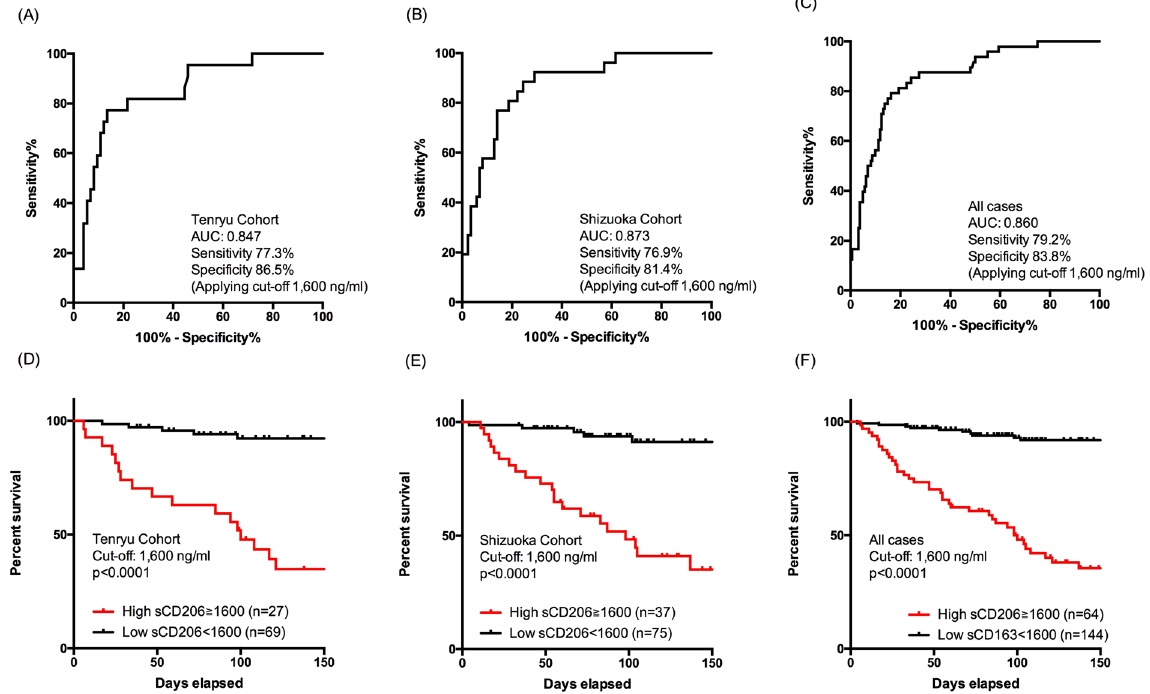
Figure 3. Receiver operator curve analysis of serum concentrations of sCD206 predicting mortality in patients with Tenryu, Shizuoka, and combined cohorts ( A – C ). Kaplan-Meier curves of patients with Tenryu, Shizuoka, and combined cohorts according to serum sCD206. P values were determined by the log rank test ( D – F ).